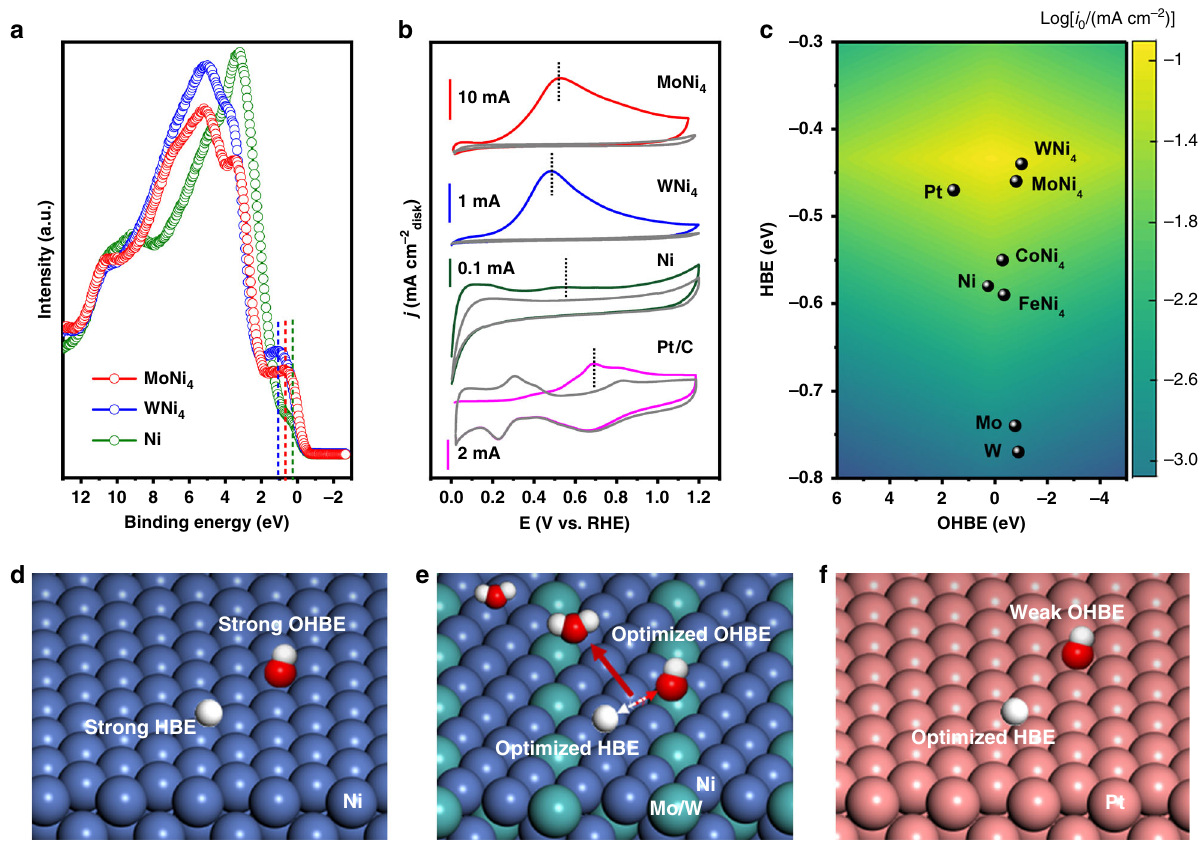
Fig. 5 HBE and OHBE. a UPS spectra of MoNi 4 , WNi 4 , and freshly synthesized Ni catalysts. b CO-stripping measurements on MoNi 4 , WNi 4 , and freshly synthesized Ni and Pt/C catalysts. Sweep rate: 20 mV s − 1 . Rotation speed: 1600 r.p.m. The gray curves in b show the second cycle of the measurements. c The experimentally measured exchange current density normalized by ECSA, log( j 0 ), for the HOR in 0.1 M KOH on different catalysts plotted with the calculated H and OH binding energies. d – f Schematic illustration of hydrogen and hydroxyl adsorption on freshly synthesized Ni, Mo(W)Ni 4 alloys, and Pt,